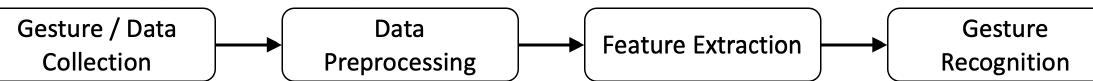
Figure 8. An overview of the different algorithmic steps applied in our